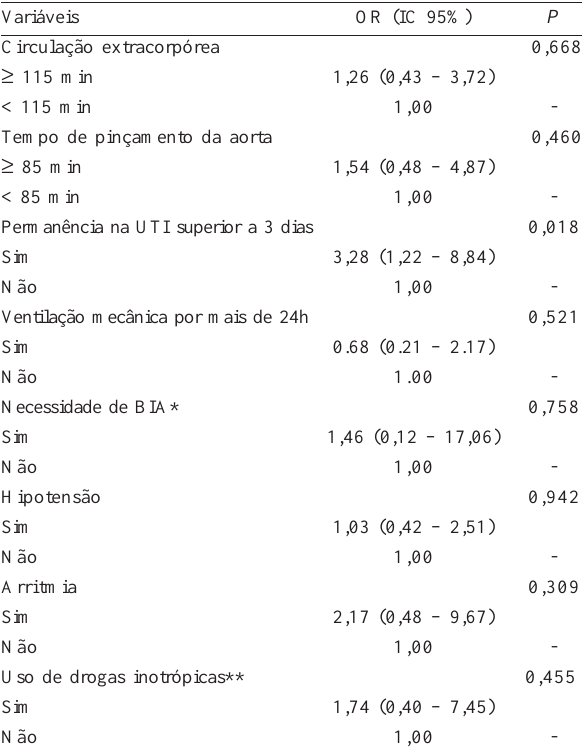
Tabela 5. Análise multivariada dos fatores de risco para IRA em pacientes submetidos à cirurgia de revascularização do